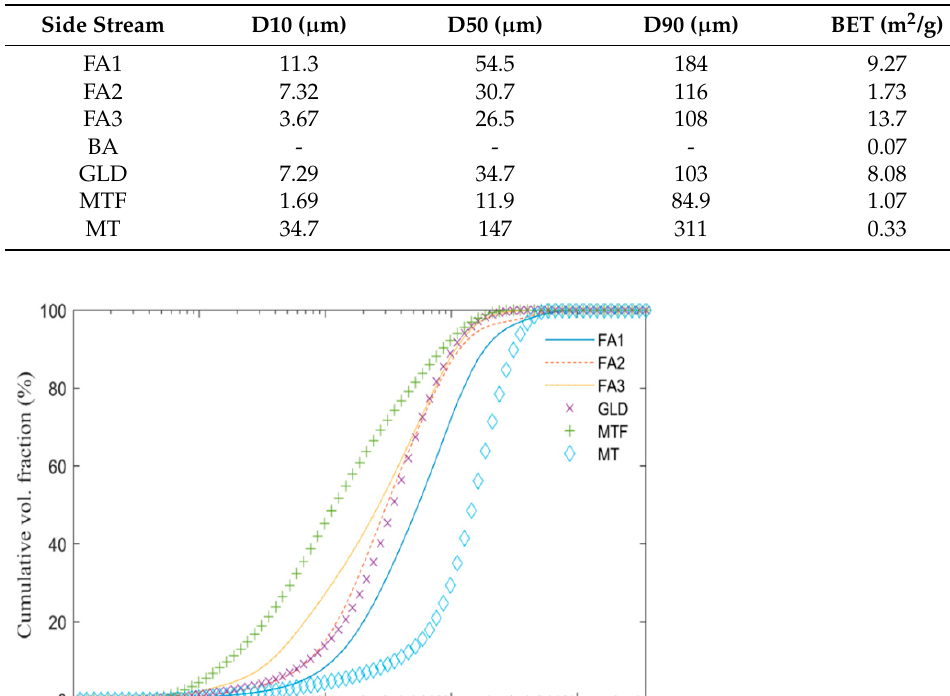
Table 3. Particle size distribution values (D10, D50, D90) and BET specific surface areas of the side streams.